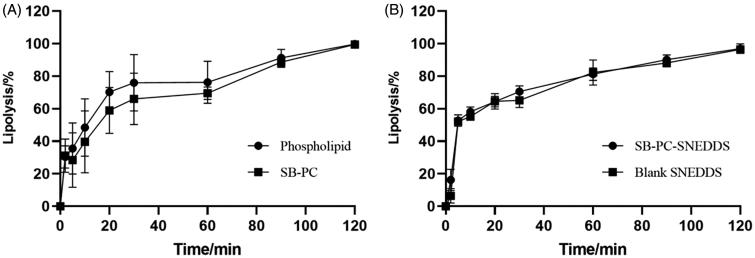
Time dependence of the lipase-mediated digestion of SB–PC and SNEDDS (n = 3).